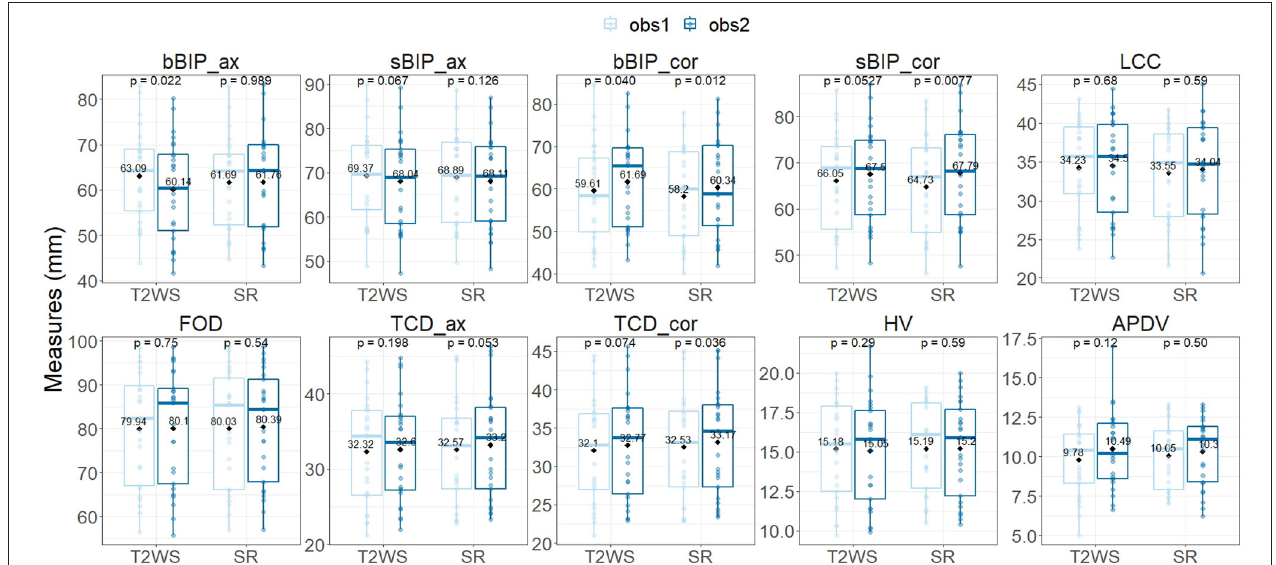
FIGURE 7 | Inter-observer intra-dataset comparison for each biometric measurement using the paired Wilcoxon signed rank test. Vertical y-axis, measurement in mm for each biometric measurement for each fetal brain MRI exam (point) for T2-weighted sequence (T2WS) and super-resolution (SR) (horizontal x-axis) for observer 1 (light blue) and observer 2 (dark blue). Solid horizontal lines depict the median; diamonds depict the average of measurement in mm. See Figure 3 for measurement abbreviations. p < 0.05 is considered significant.